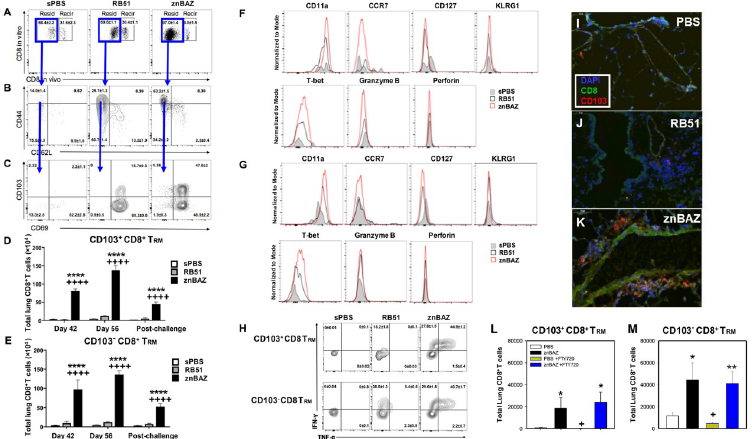
Fig 6. Mucosal znBAZ vaccination enhances the infiltration of CD103 + and CD103 - CD8 + T RM cells into the lungs. BALB/c mice were primed and boosted with sPBS, RB51, and znBAZ as described in (Fig 1A). Mice were analyzed for the expression of memory CD8 + T cell subsets on days 42 and 56 (pre-challenge), as well as at day 84 (post-challenge with wt B . abortus 2308). (A) Flow cytometric analysis of lung CD8 + T cells following in vivo labeling on day 56. (B) FACS plots show the percentage of cells expressing CD62L and CD44, and (C) CD69 and CD103. (D, E) Total number of CD103 + and CD103 - CD69 + CD8 + T RM cells in the lungs at various time points. The data depict n = 12 mice per group combined from three independent experiments. The differences were determined when compared to sPBS-dosed mice ( ���� P < 0.0001, ��� P < 0.001, �� P < 0.01, � P < 0.05), or compared to RB51-vaccinated mice ( ++++ P < 0.0001, +++ P < 0.001, ++ P < 0.01, + P < 0.05). The differences amongst the time points were determined when compared to day 42 ( †††† P < 0.0001, ††† P < 0.001, †† P < 0.01, † P < 0.05), or compared to day 56 ( ‡‡‡‡ P < 0.0001, ‡‡‡ P < 0.001, ‡‡ P < 0.01, ‡ P < 0.05). Analysis of variance with Two-way ANOVA Tukey’s multiple comparisons test was performed. (F-G) Representative expression of CD11a, CCR7, CD127, KLRG1, T-bet, granzyme B, and perforin by (F) CD103 + and (G) CD103 - CD8 + T RM cells from the lung at day 56 after oral prime are depicted. (H) IFN- γ and TNF- α production by CD103 + and CD103 - CD8 + T RM cells from the lungs on day 56 are shown. (I-K) Immunofluorescent staining for CD8 + T cells expressing CD103 reveals the presence of CD103 + and CD103 - CD8 + T RM cells in the lungs of (K) znBAZ-vaccinated mice, and to a lesser extent in (I) PBS-dosed or (J) RB51-vaccinated mice. Magnification is 400x, and line depicts 50 μ m in length. Data are representative of 3–5 mice per group. (L, M) Parenteral administration of FTY720 for one week beginning one day prior to nasal B . abortus 2308 challenge showed no significant change in (L) CD103 + and (M) CD103 - CD8 + T RM cells relative to untreated znBAZ-vaccinated mice; �� P < 0.01, � P < 0.05 versus respective PBS-dosed group and + P < 0.05 between untreated PBS-dosed and FTY720-treated, PBS-dosed